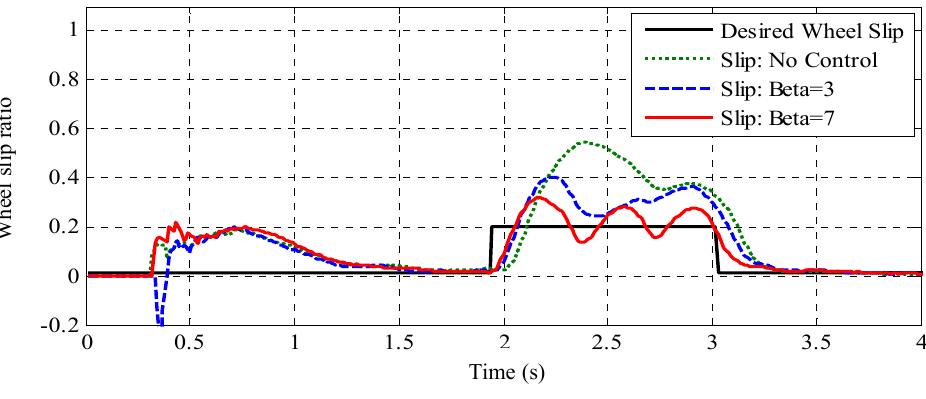
Figure 16. Experimental results for the proposed wheel slip controller: wheel slip